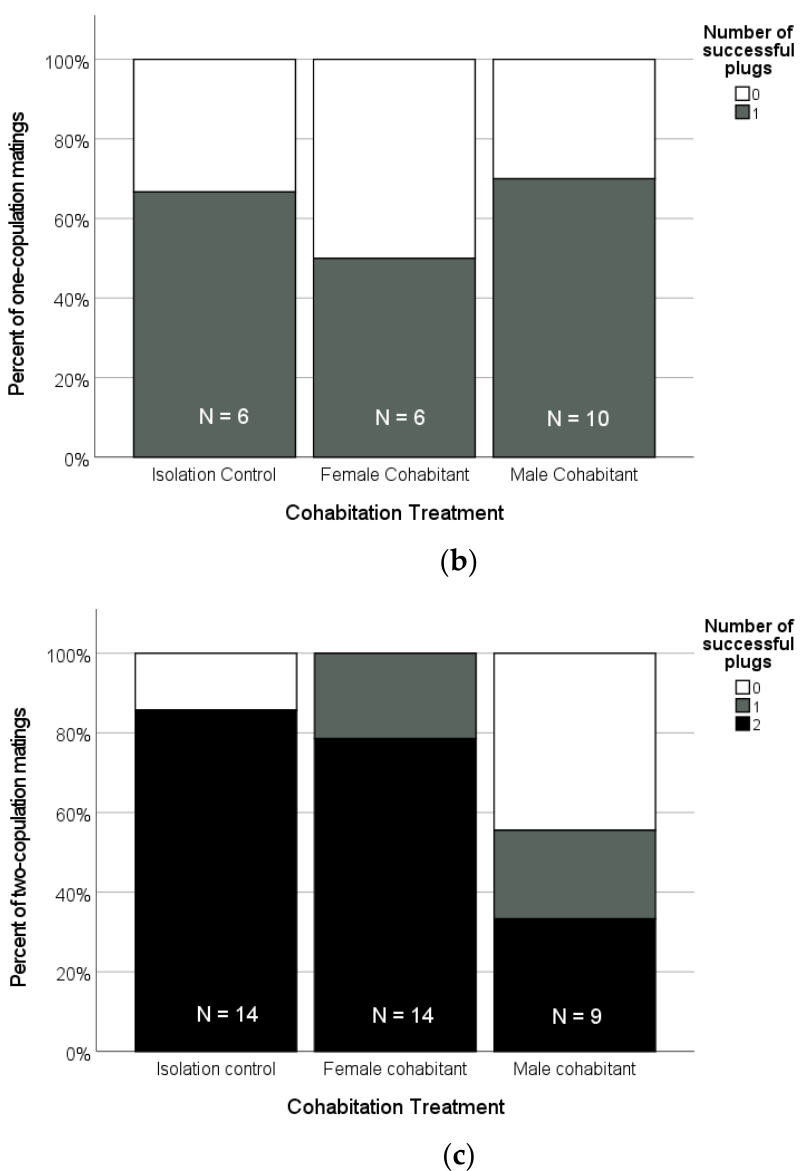
Figure 7. ( a ) Percent of all matings that ended with females retaining a given number of the males’ apical sclerites lodged at the entrance to the spermatheca in a position likely to block insemination by subsequent males (0 [white], 1 [grey], or 2 [black] successful plugs). ( b ) The frequency with which different numbers of successful plugs were found after the subset of matings in which the males achieved only one copulation. ( c ) The frequency with which different numbers of successful plugs were found after the subset of matings in which the males achieved two copulations. In all panels, the total sample size for each treatment is shown just above the X